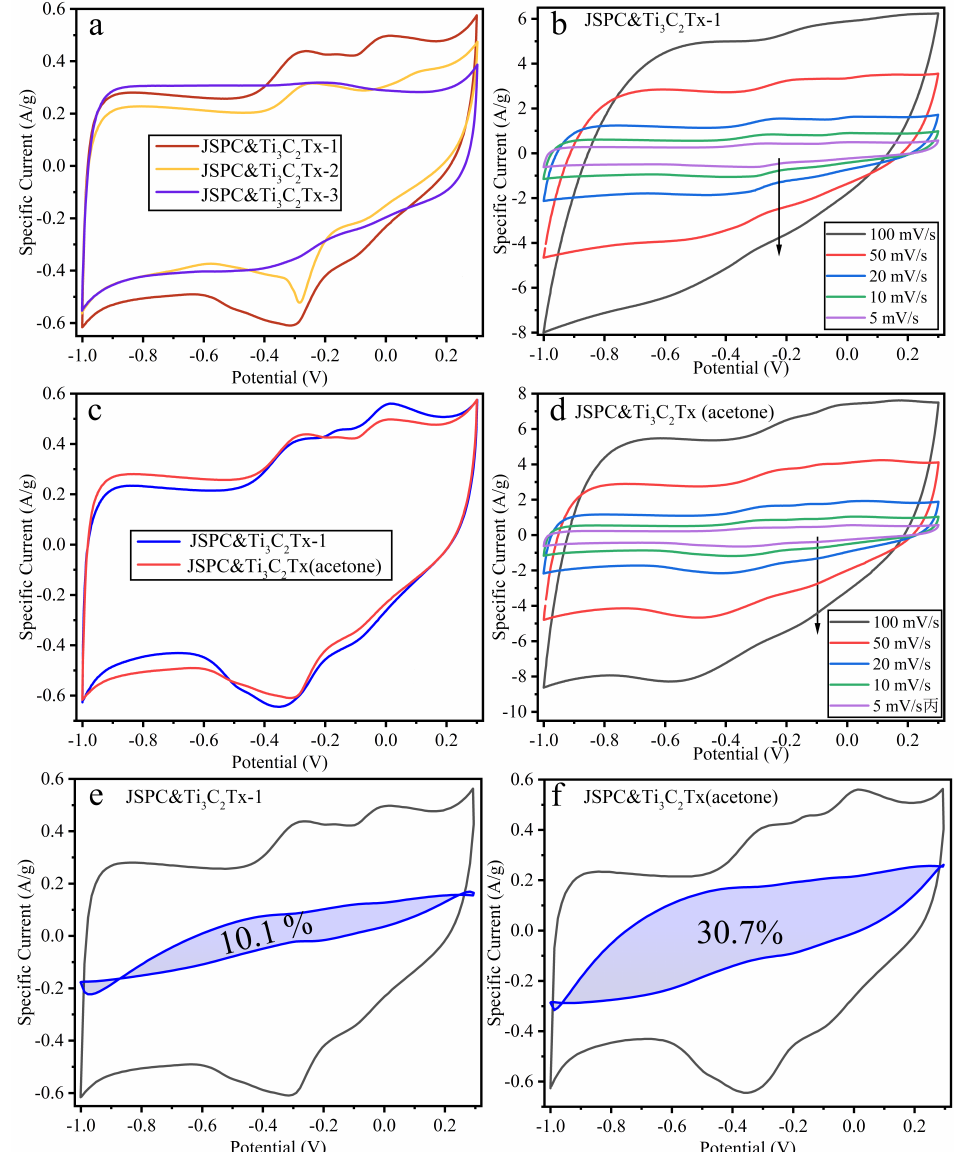
Figure 4. Comparison of CV curves and the proportion of pseudocapacitors in the composites. ( a ) is the CV curves of JSPC&Ti 3 C 2 Tx at 5 mV/s. ( b ) refers to the CV curves of JSPC&Ti 3 C 2 Tx at